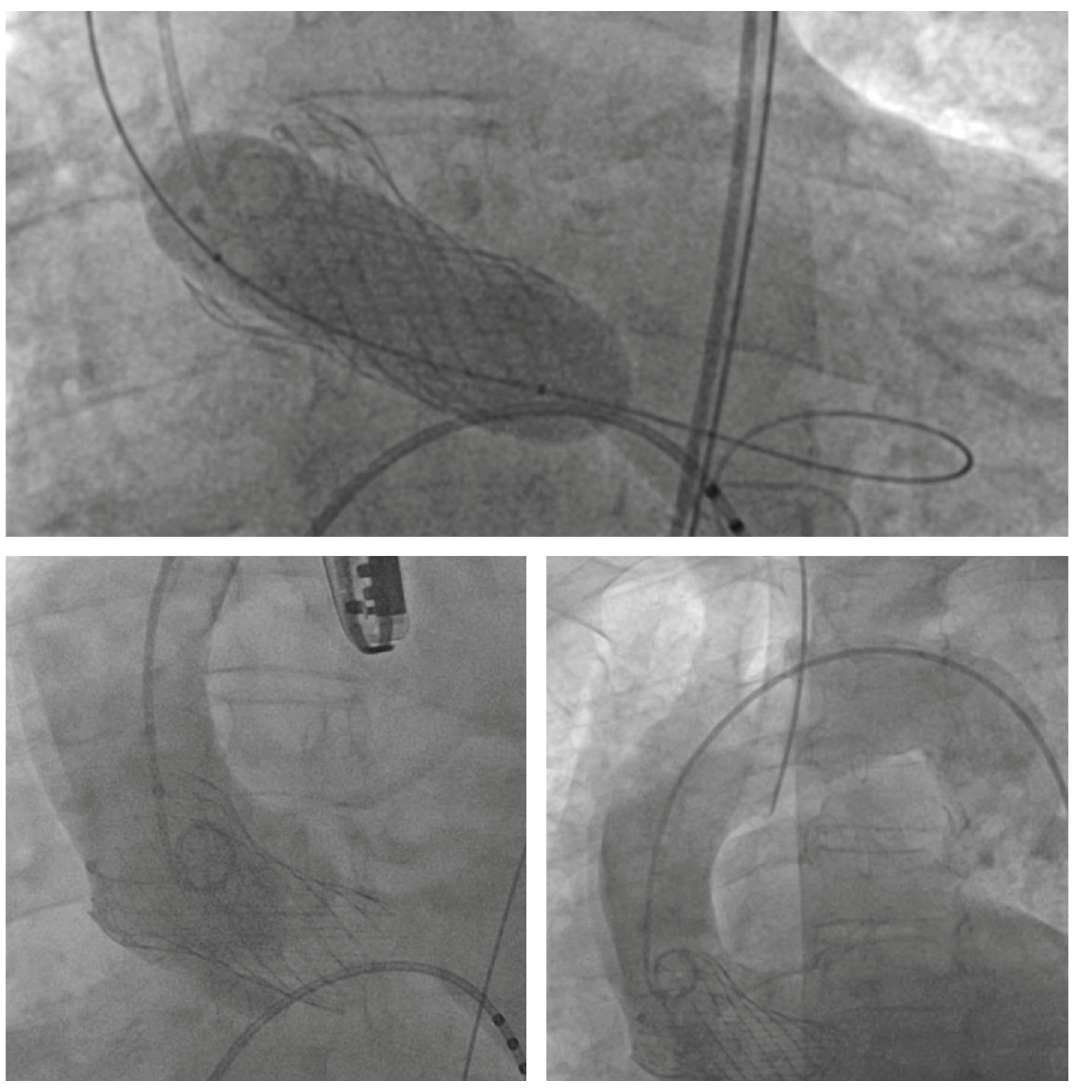
Figure 1: TAVI procedure and ascending aorta